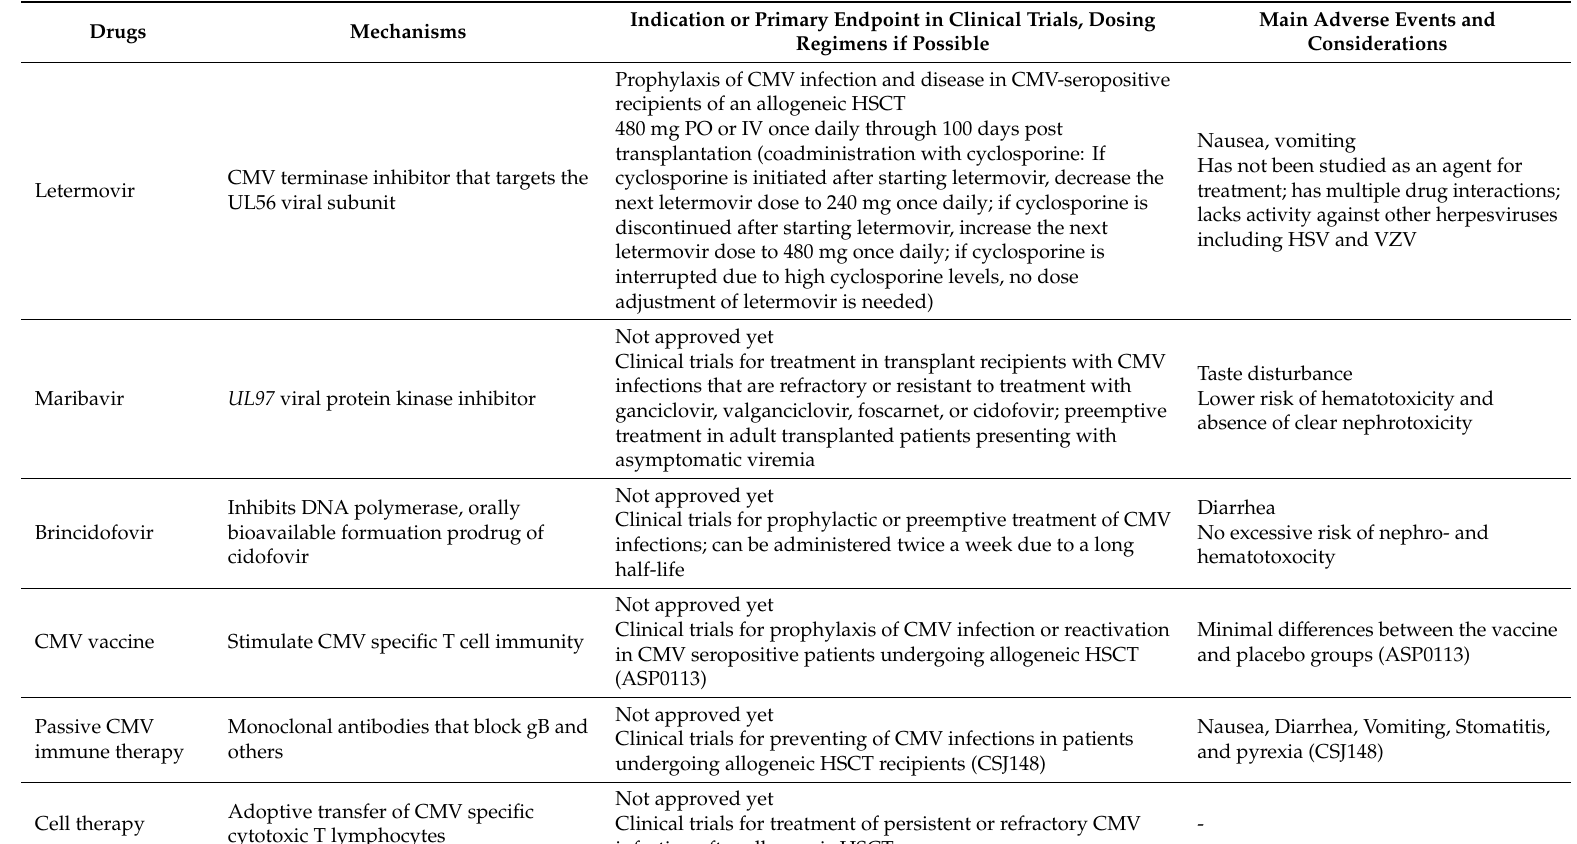
Table 2. New antiviral agents or strategies for managing